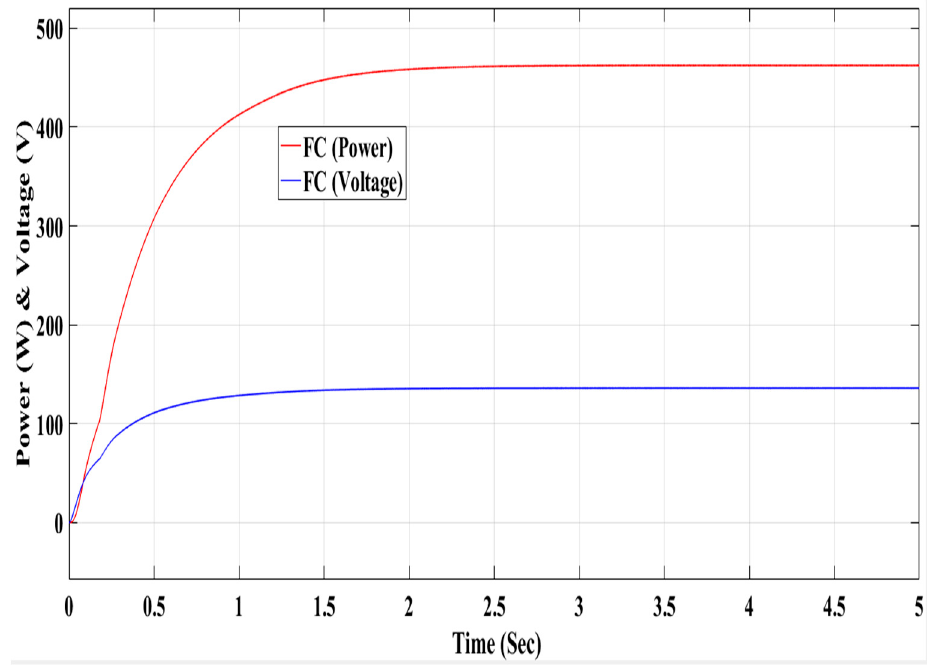
Figure 27. Power and voltage characteristics of the FC model using a fuzzy logic controller.